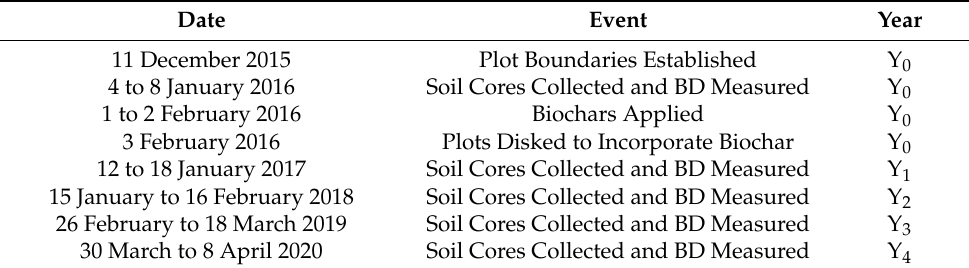
Table 2. Dates of plot creation, biochar application, soil incorporation, soil core collection and bulk density (BD) measurements during years (Y) of field